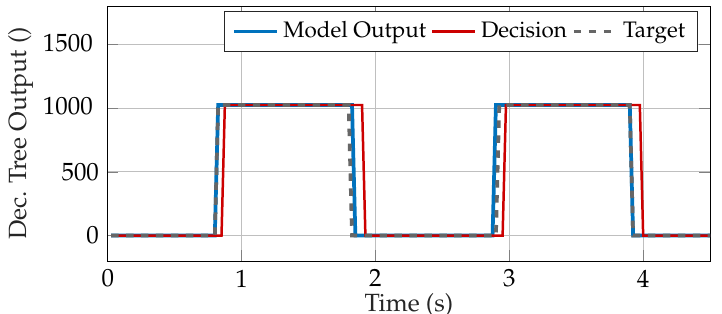
Figure 8. Output, decision and target of the selected decision tree for a window of the test data, corrected by the signal delay (Section 2.8.3). The target value is 1024 (= 1 in floating-point format) for contractions and 0 for artifacts. A decision of 1024 leads to an activation of the prosthesis drive. Decisions for artifacts maintain the current output value or turn off the prosthesis drive, depending on the selected policy.